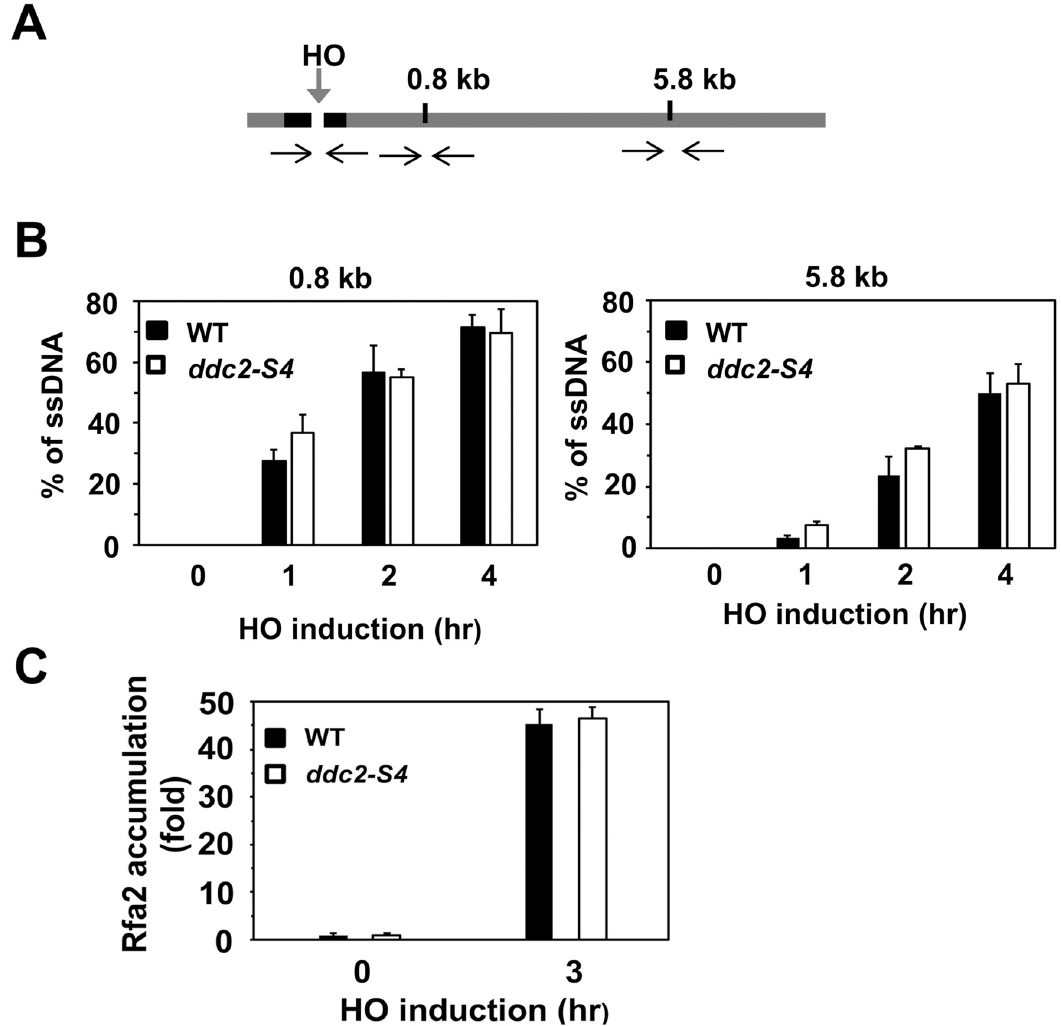
Fig 2. Effect of ddc2-S4 mutation on DNA end resection and RPA accumulation. (A) Scheme of the ADH4 locus containing a HO cleavage site. One EcoRI restriction site is located 0.8 kb away from the HO cleavage site whereas another is 5.8 kb away. The black arrows indicate PCR primer pairs to monitor HO or EcoRI cleavage. (B) Effect of ddc2-S4 mutation on DNA end resection. Wild- type (HB01) or ddc2-S4 (HB02) cells carrying YCpA-GAL-HO were grown in sucrose and treated with nocodazole. After arrest at G2/M, the culture was incubated with galactose to induce HO expression. Cells were collected at the indicated times for genomic DNA preparation. Genomic DNA was digested with EcoRI and analyzed by real-time PCR. Experiments were carried out three times. The error bars indicate standard deviation. (C) Effect of ddc2-S4 on Rfa2 localization to a HO-induced DSB. Wild-type (HB01) or ddc2-S4 (HB02) cells were transformed with the YCpA-GAL-HO plasmid. Transformed cells were grown in sucrose and treated with nocodazole. The culture was then incubated with galactose for 3 hr to induce HO expression, while half of the culture was maintained in sucrose to repress HO expression. Cells were subjected to chromatin immunoprecipitation with anti-Rfa2 antibodies. Association of Rfa2 with a HO-induced DSB was analyzed by real-time PCR. Relative enrichment was determined from three independent experiments. The error bars indicate standard